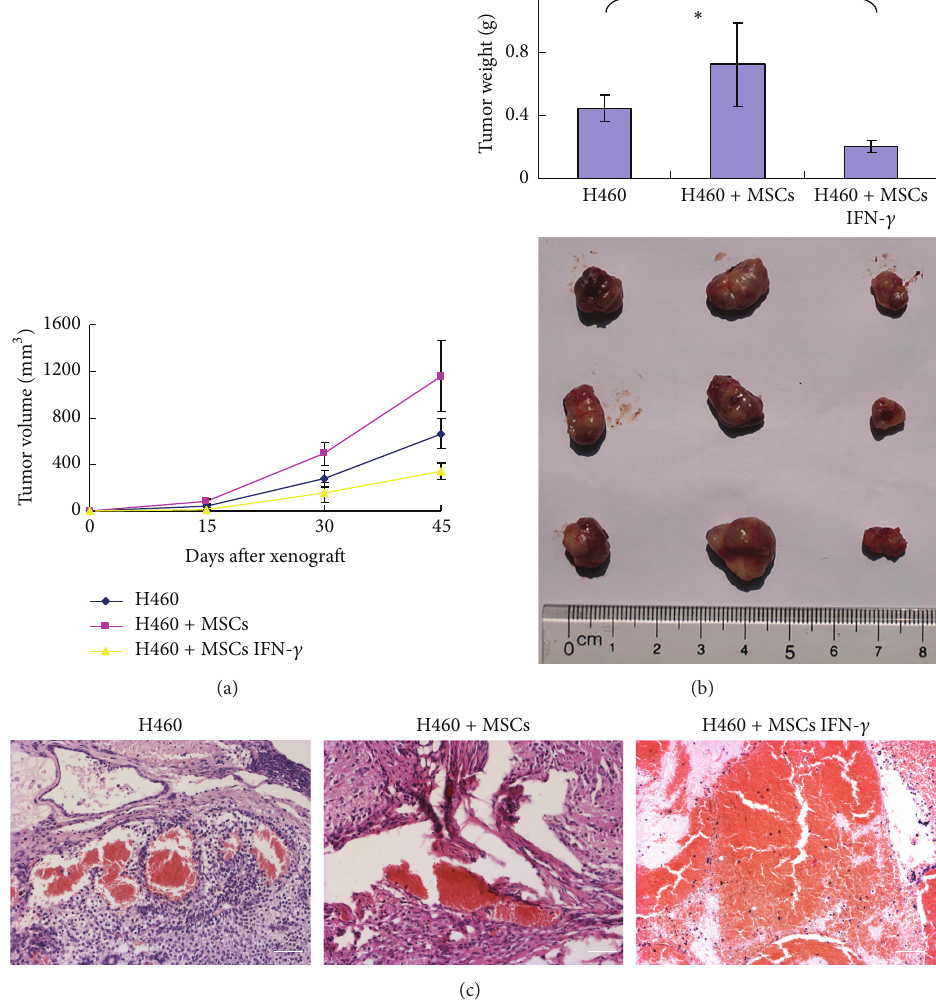
Figure 5: MSCs IFN- 𝛾 inhibit tumor mass growth in nude mice. (a) Tumor sizes were dynamically monitored after H460 cells combined with or without MSCs or MSCs IFN- 𝛾 were injected into nude mice ( 𝑛 = 3 mice/group, three separate experiments). (b) The tumor mass weight and morphology were compared at the end of the incubation period in vivo . The asterisks indicate 𝑃 < 0.05 . (c) Hematoxylin and eosin (H&E) staining of xenograft tumor. Tumor mass containing MSCs IFN- 𝛾 showed a serious extent of necrotic area, compared with the other two